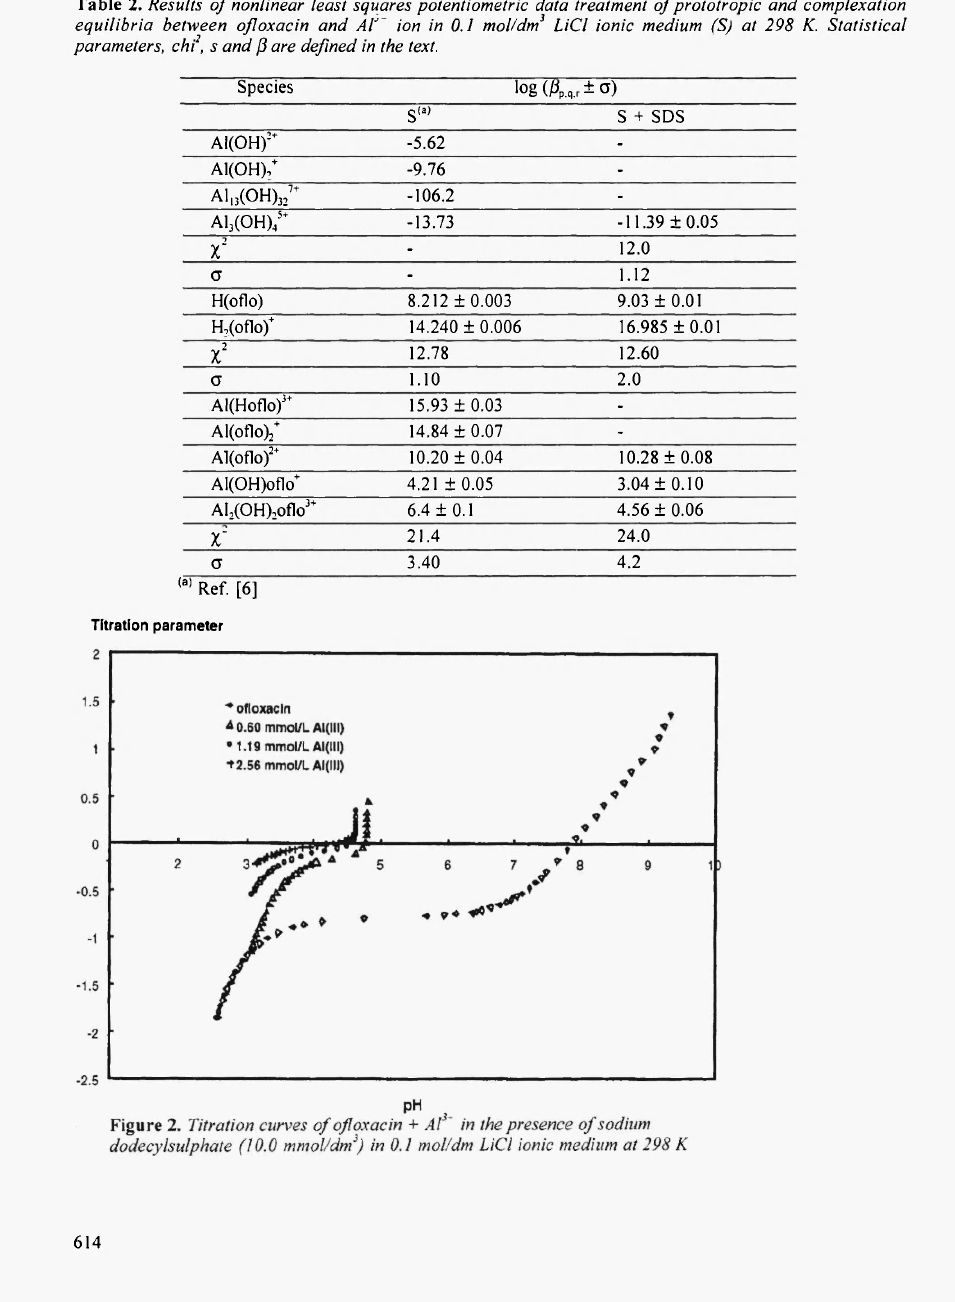
Table 2. Results of nonlinear least squares Potentiometrie data treatment of prototropic and complexation equilibria between ofloxacin and